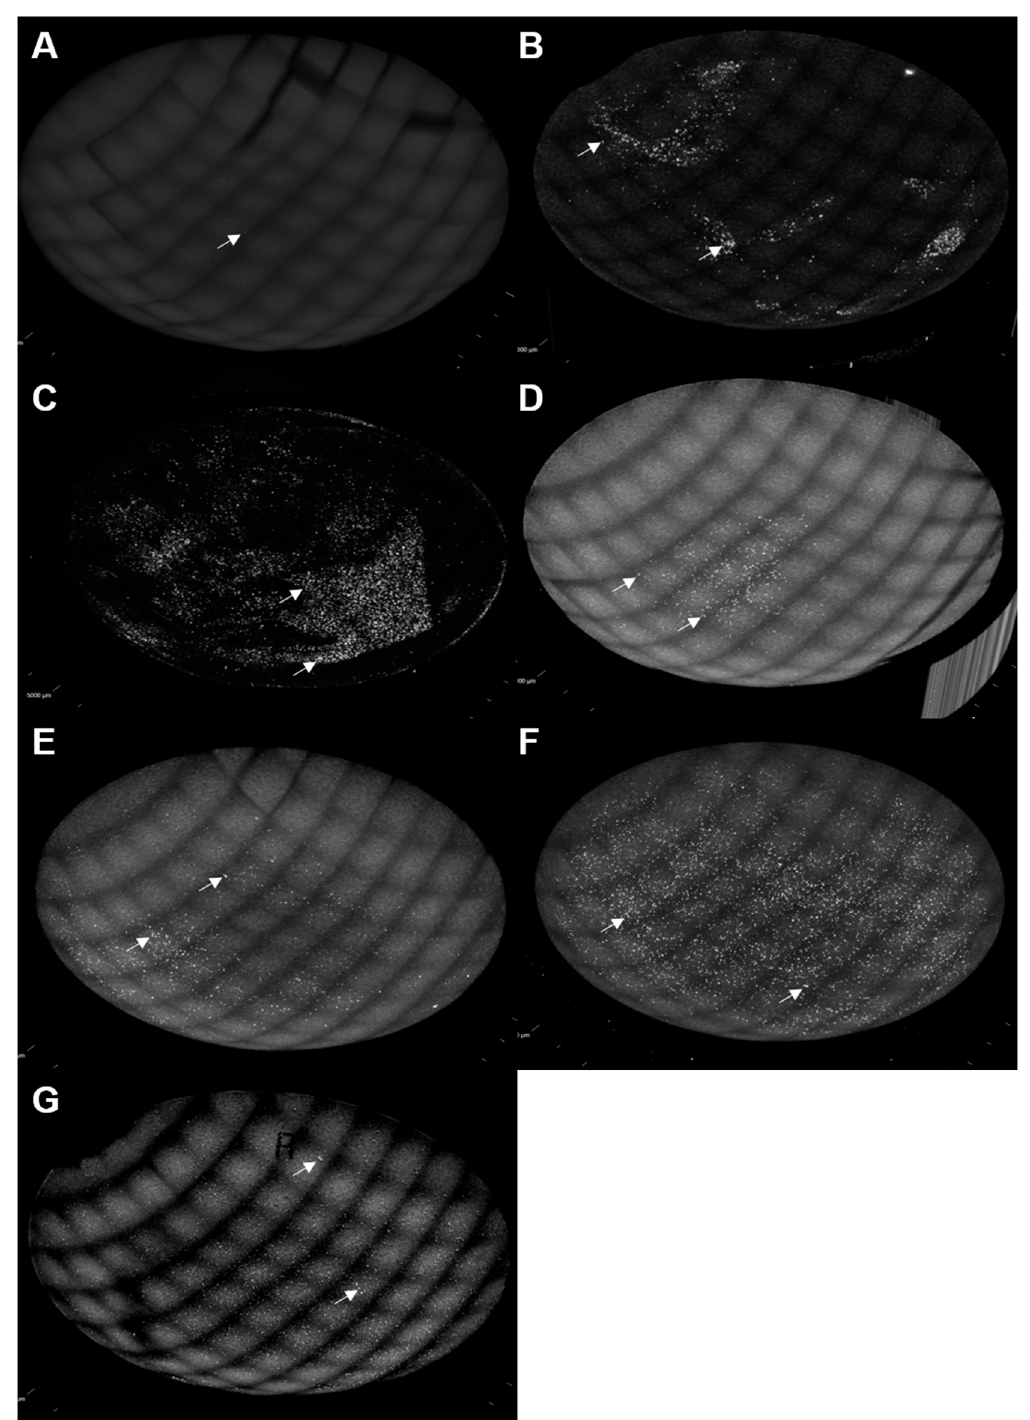
Figure 5. Whole lens confocal microscopy of contact lenses colonized with TAMRA-stained S. marcescens . Composite whole-lens images of lehfilcon A ( A ), comfilcon A ( B ), omafilcon B ( C ), fanfilcon A ( D ), senofilcon A ( E ), senofilcon C ( F ), and balafilcon A ( G ) were stitched from fields collected at 10× magnification. Arrows indicate examples of foci of S. marcescens adhered to the contact lens surfaces.